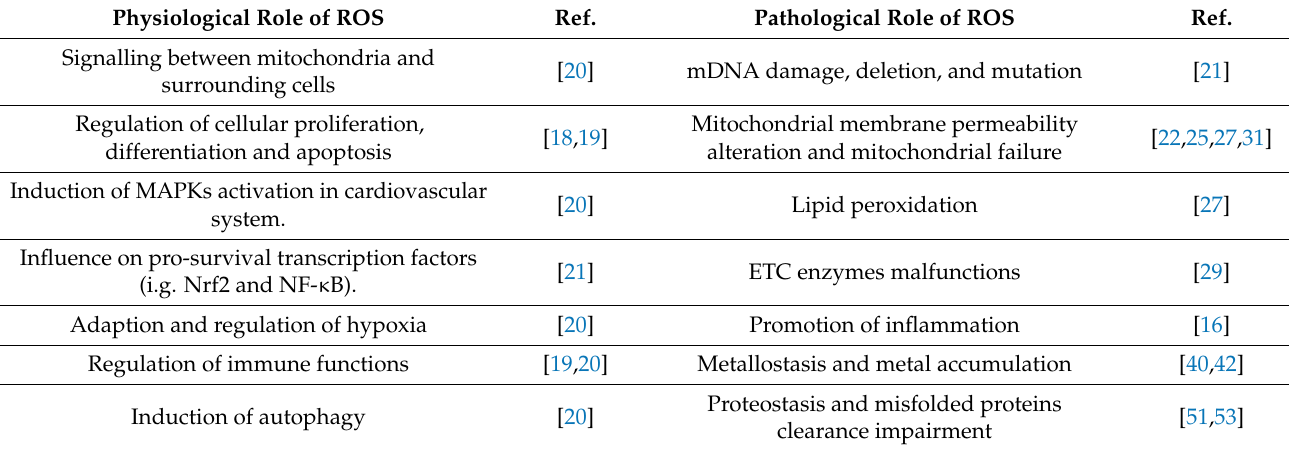
Table 1. Main physiological and pathological roles of